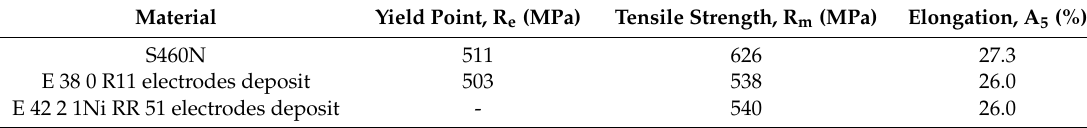
Table 2. The mechanical properties of used materials in accordance with the manufacturer